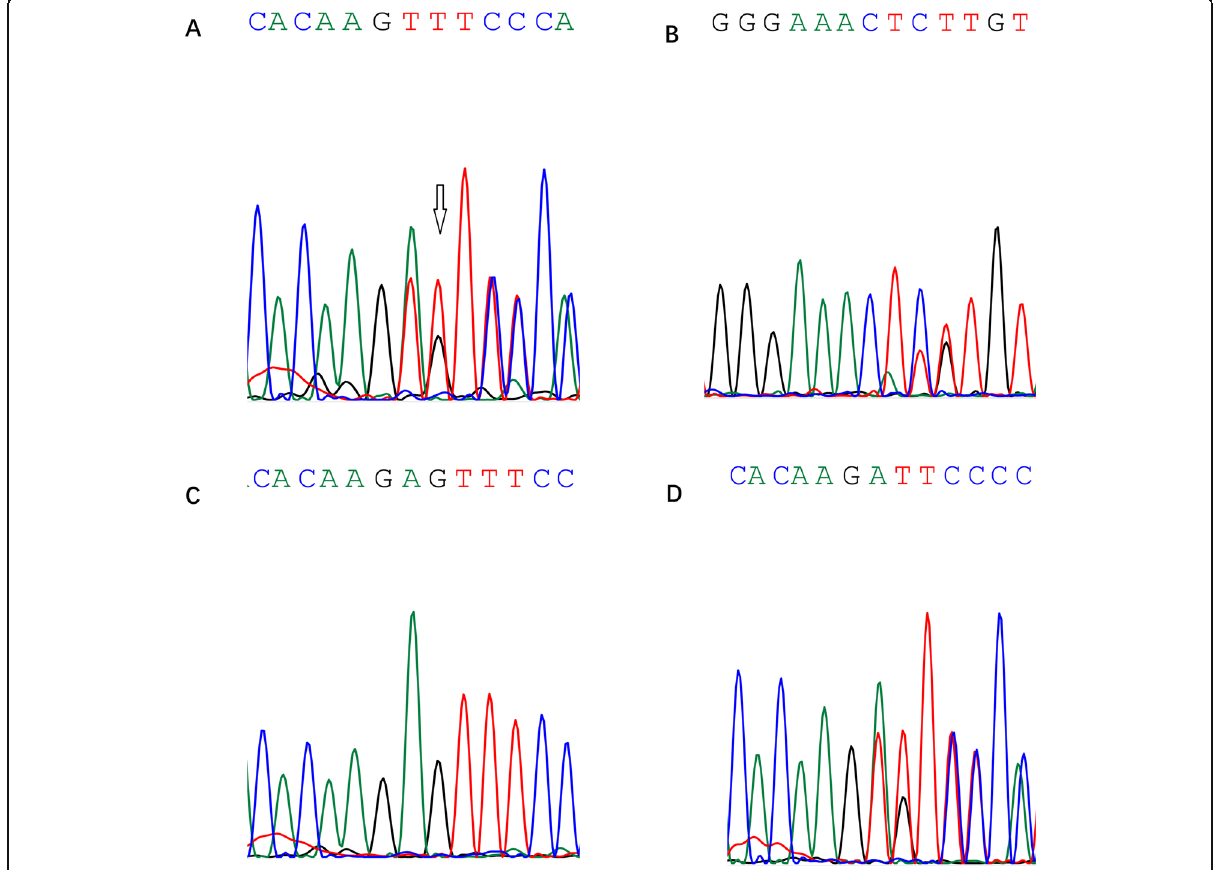
Fig. 3 Partial electropherograms of the genomic region covering the genes: The heterozygous PMM2 c.241-242del variant. Arrows denote the mutations. a the proband; b the younger affected brother; c the unaffected father; d the unaffected